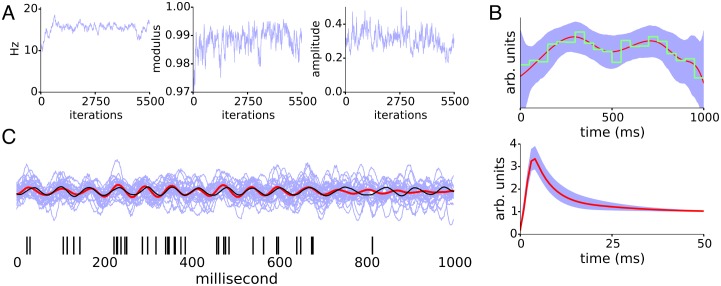
LIF neuron with stimulus-triggered change in firing rate.Phase inference for simulated LIF neuron driven by irregular oscillation with an average firing rate of 40Hz and a 15Hz modulating oscillation with OCV of 0.13. 60 trials of 1 second duration were used for LOST. A) Samples of the representative AR parameters. B) Top, samples of the TAE (cyan), the mean (red), and the empirical PSTH used to initialize TAE knot locations (green), and bottom, samples (cyan) of the spike history and mean (red). C) Example of inferred latent oscillation. The RL of the inferred oscillation is 0.65 ± 0.02, while the spike train has an R of 0.22 ± 0.01 with the ground truth oscillation.